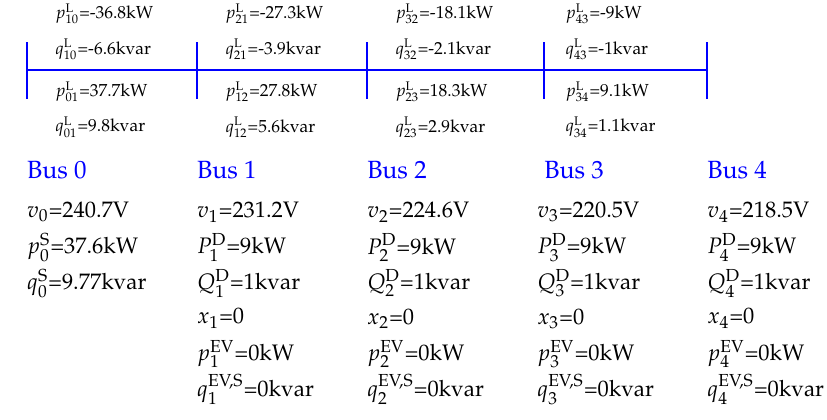
Figure 3. Illustrative example: Results of problem (P1) without reactive power droop curve.